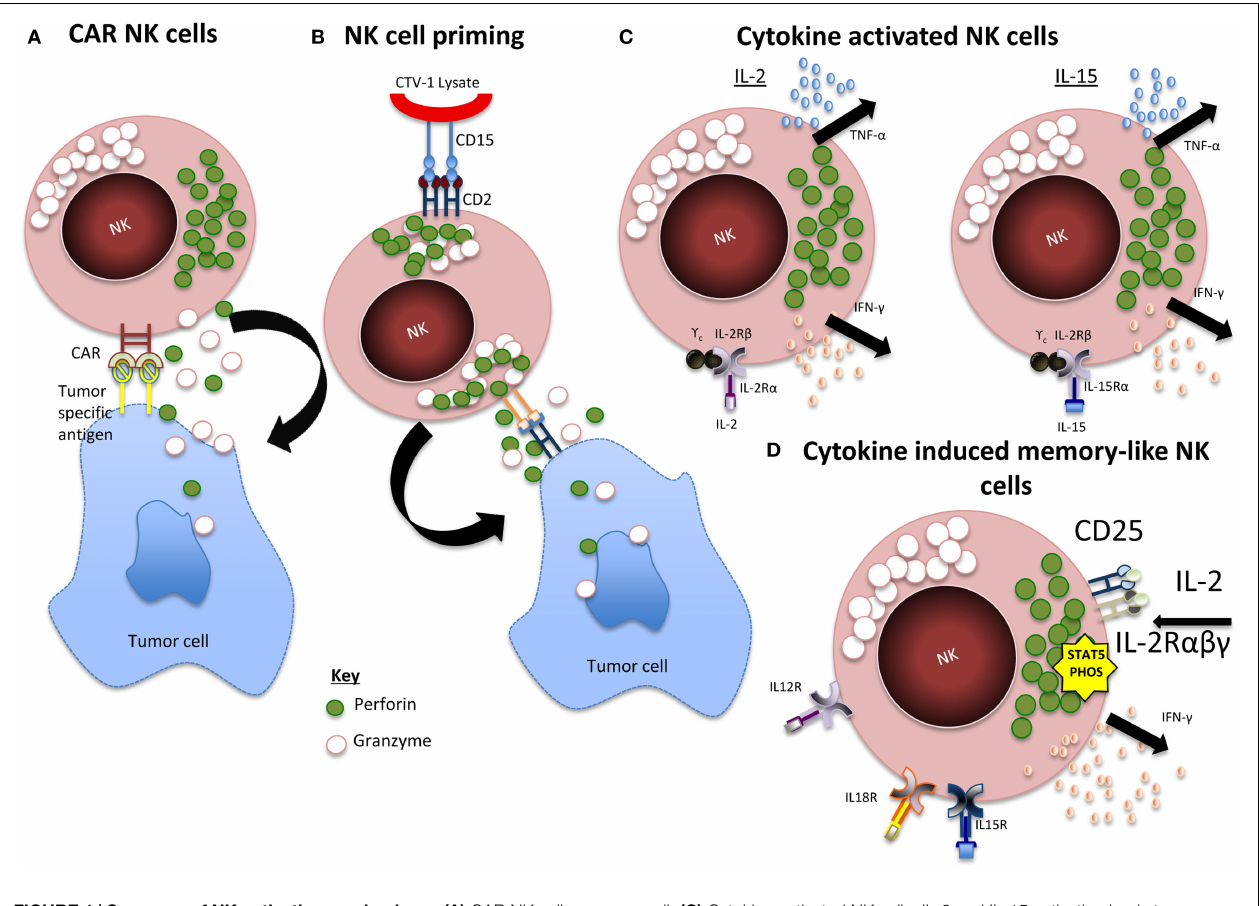
FIGURE 1 | Summary of NK activation mechanisms . (A) CAR NK cells. Expression of chimeric antigen receptor (CAR) specific for tumor-associated cell surface antigens redirects NK cells to malignant cells and facilitates cytotoxic activity. (B) Primed NK cells. Engagement of CD2 within CD15 of CTV-1 ligand leads to granule polarization and NK cell function is triggered by the engagement of at least one more activating receptor from a tumor